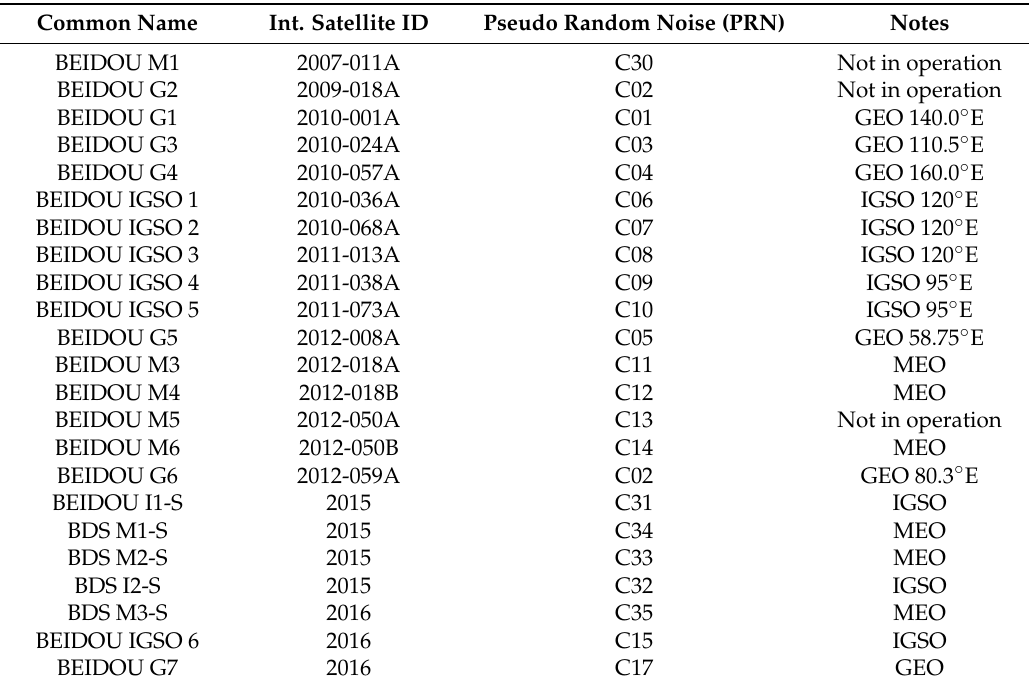
Table 1. Constellation of the BeiDou Navigation Satellite (BDS) regional system. GEO: geostationary orbits; IGSO: inclined geosynchronous orbits; MEO: medium Earth orbits. Common Name Int. Satellite